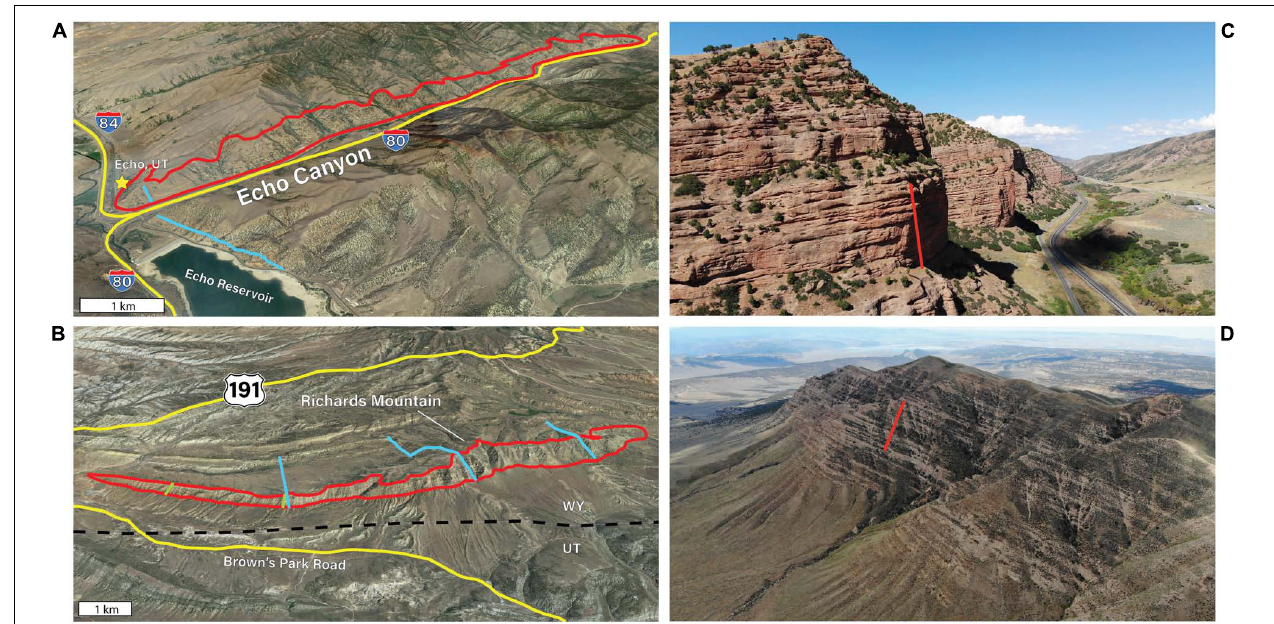
FIGURE 3 | Overview of study areas. For (A) and (B) , areas outlined in red indicate approximate extent of digital outcrop models. Blue lines indicate locations of sedimentary logs from previous workers. Green lines indicate locations of sedimentary logs measured by the authors. Roads are shown in yellow. Satellite imagery modified from Google Earth (2019). (A) Oblique view (looking north) of Echo Canyon study area. Outcrops are exposed along the north side of Echo Canyon, immediately northeast of the town of Echo, UT. Area outlined in red is approximately 11 km long. Sedimentary log from DeCelles (1994). (B) Oblique view (looking north) of the Richards Mountain study area. Richards Mountain is located in southwestern Wyoming, just north of the UT-WY border and east of the intersection of US 191 and Brown’s Park Road. Sedimentary logs in blue are from Crews (1985). Logs in green measured by S. Meek. Area outlined in red is approximately 13 km long. (C) The Echo Canyon Conglomerate crops out in sheer red cliffs over the first 11 km of Echo Canyon in northeastern Utah. View is to the northeast. Red line is approximately 60 m long. Red cliffs are predominantly clast-supported massive conglomerate with interbedded sandstone. Slope covered sections generally correspond to paleosols and/or mudstones. (D) The Richards Mountain Conglomerate is exposed in the 13 km hogback that forms Richards Mountain in southern Wyoming, just north of the Uinta Mountains. View is to the west. Red line is approximately 200 m long. Light colored bands are thick conglomerate beds. Vegetation-covered areas largely correspond with